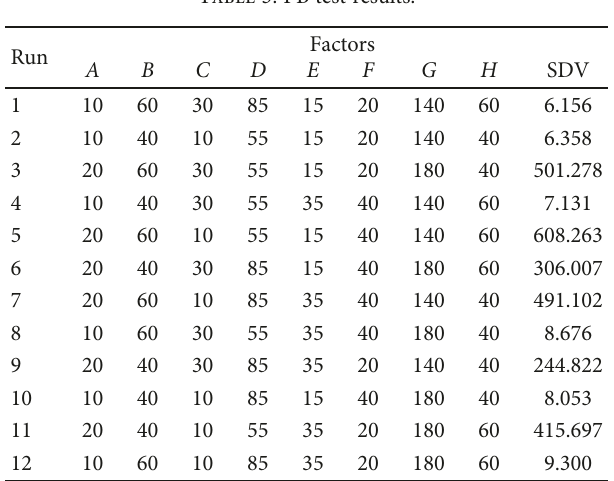
Table 3: PB test